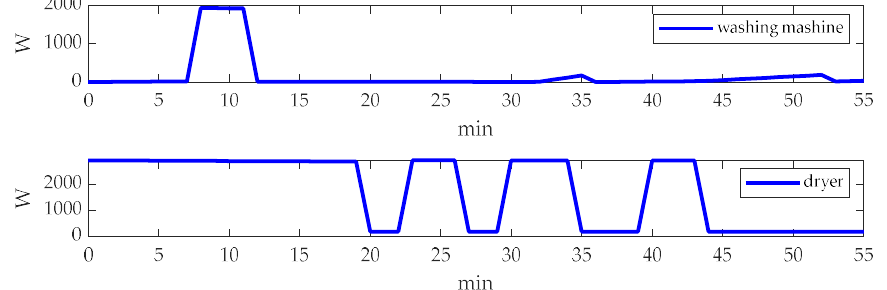
Figure 25. Load profiles used in experiment (sampling time 1 min).